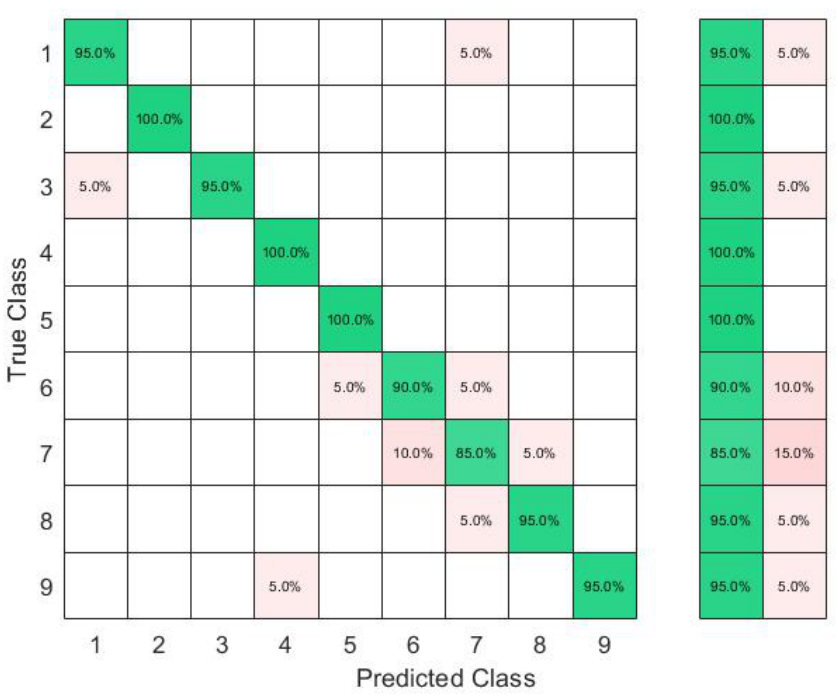
Figure 7. Confusion matrix of the KTGEL for ten person and nine numbers: 8 sensors.